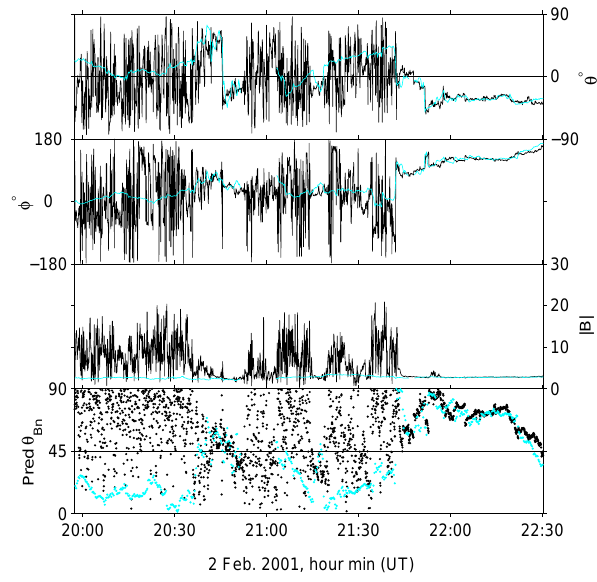
Fig. 2. The angular variations of the spin-averaged magnetic field at Cluster 1 (black) and upstream at ACE (light blue). Panels show magnetic field elevation ( θ ) and longitude ( φ ) angles in GSE co- ordinates, magnetic field magnitude ( | B | ) in nT and the angle be- tween the model bow shock normal and the magnetic field (Pred θ B n ). ACE data are lagged to give good correspondence between the magnetic field angles seen at ACE and at Cluster. When the data sets do not have clear features in common, ACE data are not plotted, for example, between ∼ 20:50 and